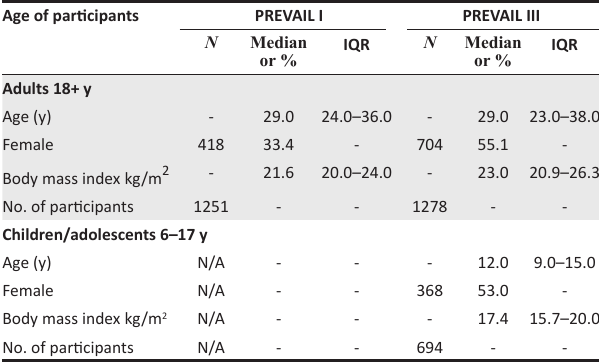
FIGURE 2: Flow diagram for inclusion of participants for determination of reference levels: Monrovia, Liberia 2015–2017. TABLE 1: Baseline characteristics of study participants in laboratory analysis: Monrovia, Liberia 2015–2017. Age of